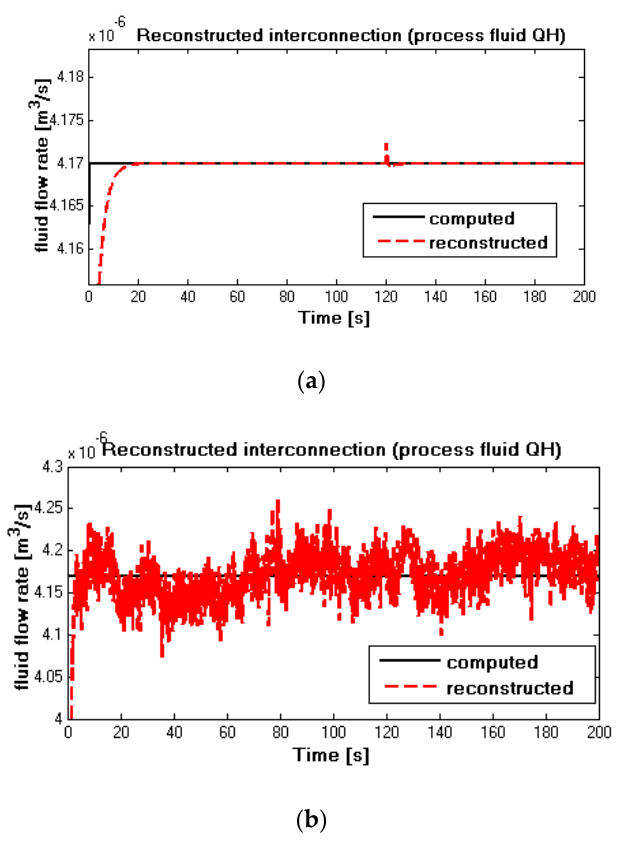
Figure 12. ( a ) Reconstructed and computed (cid:1843) (cid:3009) (noise-free situation) in case 2; ( b ) reconstructed and computed (cid:1843) (cid:3009) (noise-corrupted situation) in case 2. For the utility fluid flow rate (cid:1843) (cid:3004) in Figure 13a,b, it can be seen that the reconstructed values in red dash lines converge to the computed values in the black solid line after tran- sient time. Because of changes at 120 s, reconstructed fluid flow rates vary accordingly and reach a new stable level. Similar to the process fluid, the reconstructed utility fluid (cid:1843) (cid:3004) flunctuates significantly in the noise-corrupted situation in Figure 13b. Since the re- constructed values were retrieved from the global measured temperatures by higher-level subsystems, it can be seen that the variation of variables of the local subsystem has a sig- nificant impact on the global measurements, which is consistent with the hypothesis. Moreover, the simulation results show that the influence of noise on the reconstructed value is obviously stronger than the measured value.